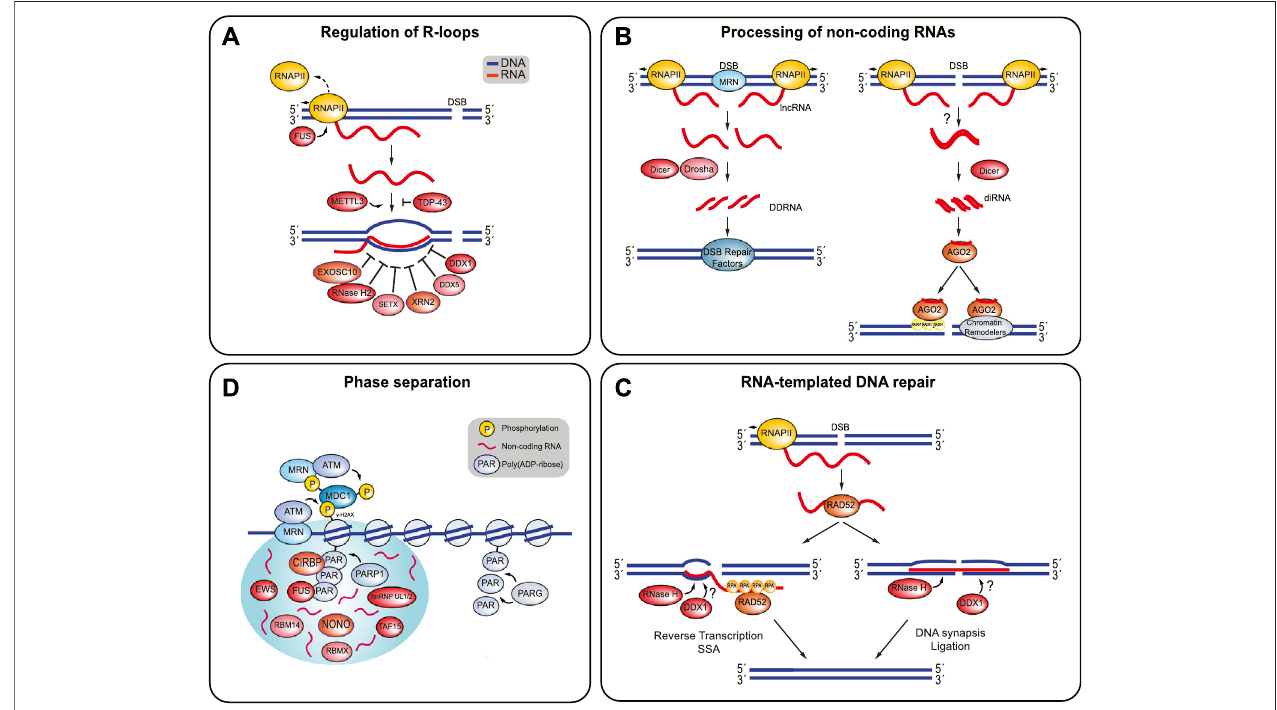
FIGURE 3 | RBPs involved in the regulation of R-loop structures, processing of non-coding RNAs, RNA-templated DNA repair, and phase separation. (A) The presence of R-loops at DSBs is highly regulated. FUS prevents R-loop formation by promoting RNAP II dissociation. TDP-43 prevents the nascent RNA from binding to DNA. METTL3 stabilizes these RNA:DNA hybrids. EXOSC10, RNase H2, SETX, XRN2, DDX5, and DDX1 are some of the RBPs involved in resolving RNA:DNA hybrids and R-loops. (B) Non-coding RNAs can be processed into DDRNAs or diRNAs. DDRNAs are produced when MRN complex induces production of dilncRNAs by recruitingRNAP IIto both ends ofthe DSB break.The dilncRNAs canbe processed by Drosha and Dicer into DDRNAs, which recruit DSB repair proteinsto theDSB. In addition, diRNAs are created when RNA transcripts are synthesized near a DSB site by RNAP IIbecome double-stranded and are processed by Dicer. It is unclear how the RNA becomes double-stranded in humans. The diRNAs are then incorporated into Argonaute-2 (AGO2) and AGO2 can then recruit RAD51. AGO2 also helps localizechromatinmodi fi ersto thebreak site, which also promotes HR. (C) RNA-templated DSB repair beginswith RAD52 binding toassRNA transcriptand facilitating RNA:DNAhybridformation.RAD52canstimulateDNArecombinationorendjoining.DNArecombinationispromotedwhenRAD52undergoesinversestrandexchange, with help from RPA. Reverse transcription and SSA annealing completes the repair process. On the other hand, RAD52 promotes end joining by bridging both ends of theDSBwiththehomologousRNAtranscript. DNAsynapsisand ligation fi nishtherepair.TheRNAtranscriptismostlikelyremovedfromtheDNAbyRNaseHenzymes and possibly DDX1. (D) PARP1 attaches poly (ADP-ribose) (PAR) chains to the DNA surrounding the DSB. Several RBPs are recruited to the DSB site in a PARP-1 dependent manner, where they may contribute promote phase separation around thebreak site. Non-codingRNAs are likelypresentand encourage phase separation. PARG disrupts phase separation and releases the RBPs by hydrolyzing the PAR